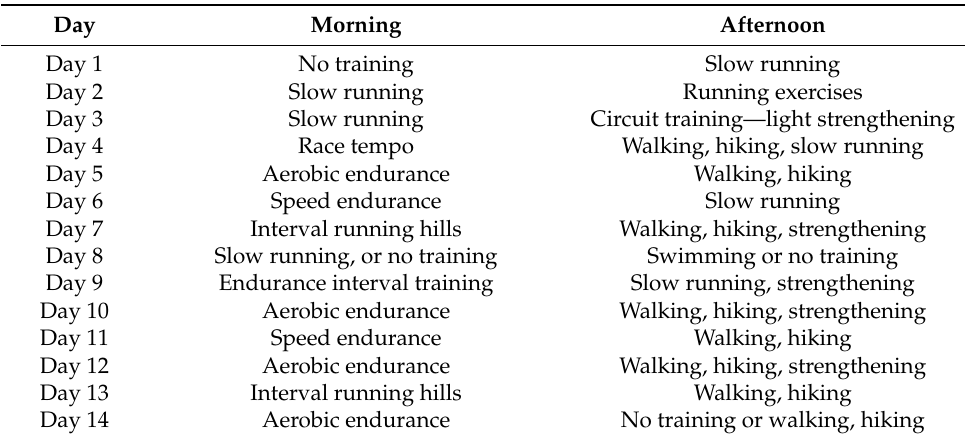
Table 1. Training plan for the training camp at higher